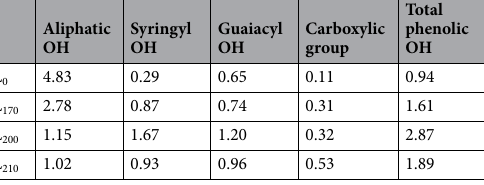
Table 4. Hydroxyl concentrations (mmol/g) of the lignin fractions L 0 , L 170 , L 200 , and L 210 obtained from Eucalyptus as determined by 31 P